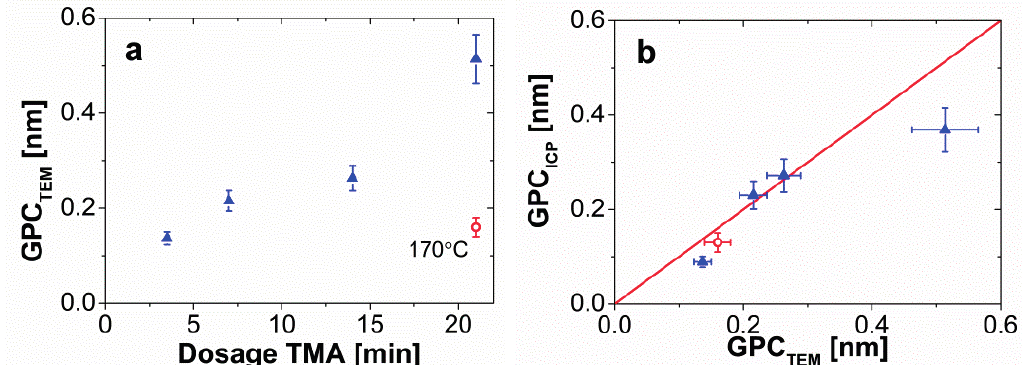
Figure 4. ( a ) GPC of the alumina film after 7 cycles with different dosing times of TMA per cycle (3.5, 7, 14, and 21 min). The red open circle represents an experiment carried out at 170 °C with a dosing time of TMA of 21 min. The error bars represent the error made in the image analysis of the TEM pictures, which is estimated to be around